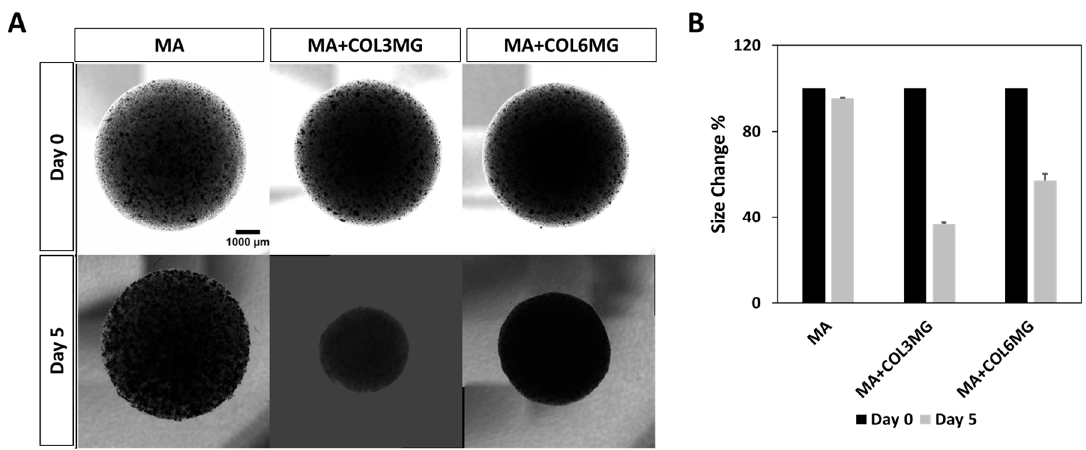
Figure 4. Effects of collagen type I on the shape ( A ) and size ( B ) of cardiomyocyte-containing hybrid hydrogels for 5 days. Note that the error bars were estimated by the standard deviation of two samples.